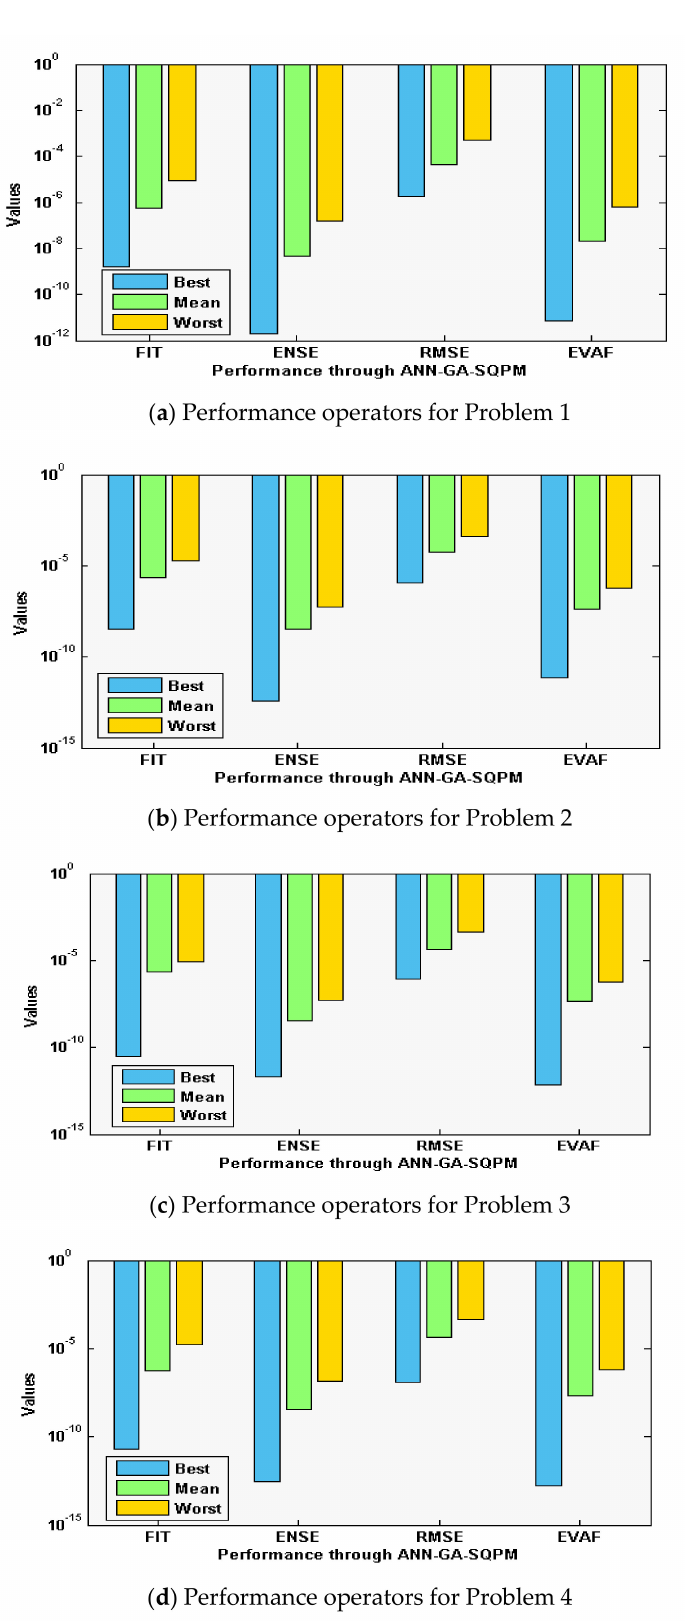
Figure 3. Performance measures through ANN-GA-SQPM to solve the singular model of Lane– Emden